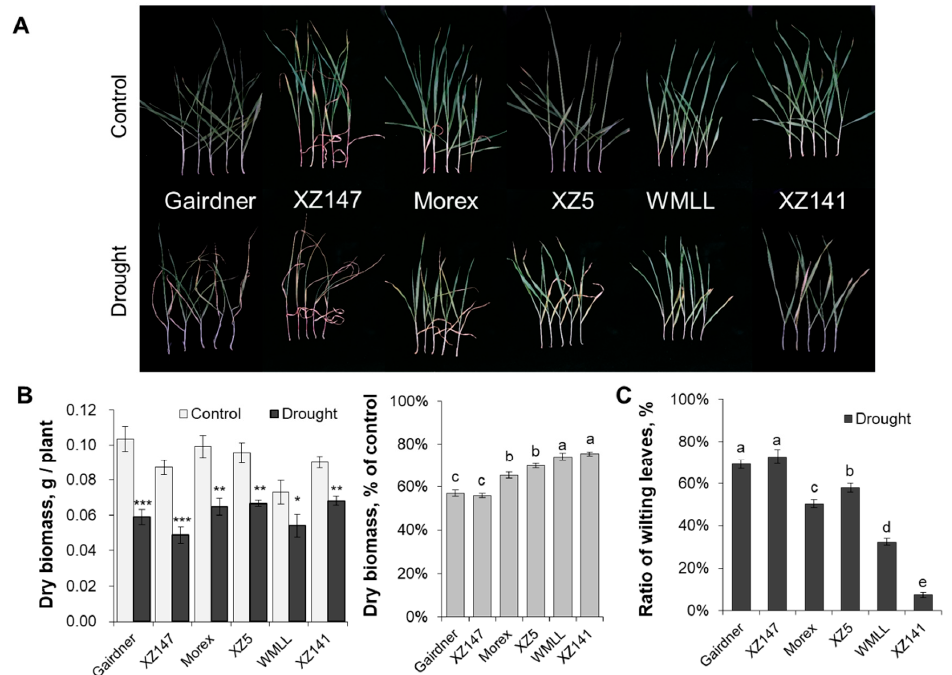
Figure 1. Effect of water-limited drought stress on plant growth of barley seedlings. Twelve-day-old barley seedlings were subjected to drought stress. Plants were harvested for morphological ( A ), biomass ( B ) and wilting leaves ( C ) analysis at 10 d after onset of treatments. Vertical bars represent means ± SE of five replicates. Asterisks indicate the significant di ff erence between treatments at * p < 0.05, ** p < 0.01 and *** p < 0.001. Di ff erent lowercase letters indicate the significant di ff erence between genotypes at p < 0.01.